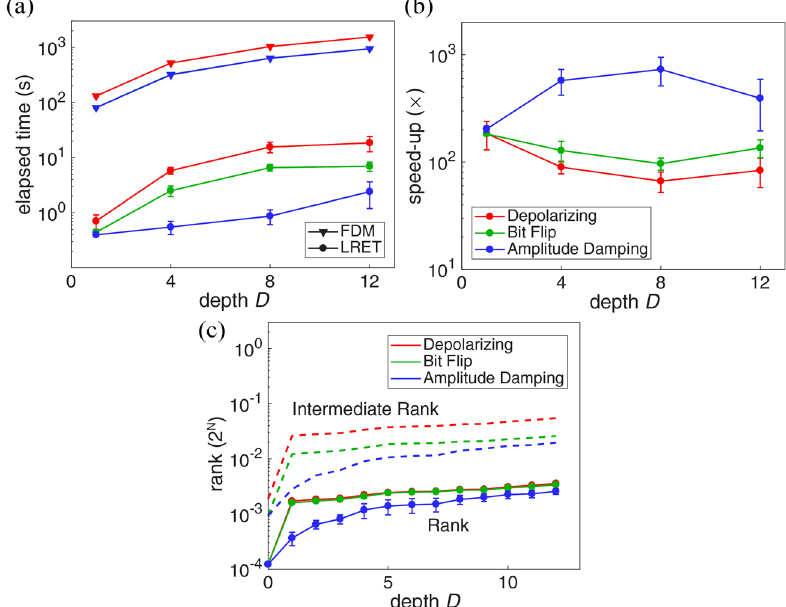
Fig. 6 Noise type benchmarking: time. a Averaged elapsed time using FDM and LRET. The color code is the same as b . b Speedup, de fi ned by the ratio of elapsed time between FDM and LRET. c The evolution of rank (solid line) and intermediate rank (dashed line) for different D . Parameters are p = 0.1%, N = 13, and ϵ = 10 − 4 . The error bars are standard-deviation-calculated across a set of simulations.